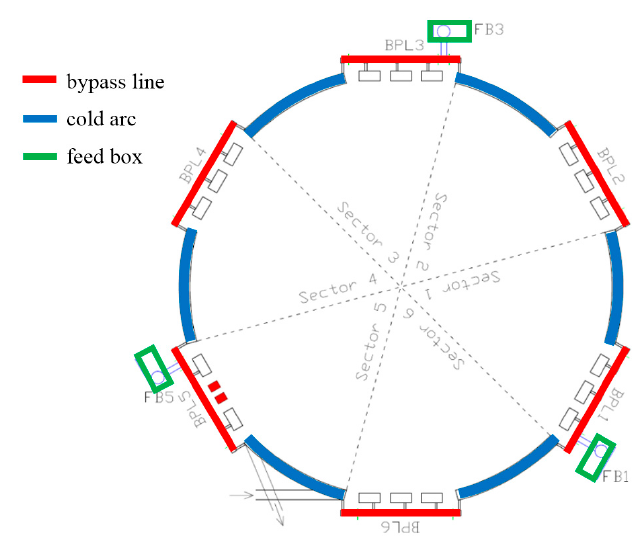
Figure 2. Schematic representation of the SIS100 accelerator showing the six bypass line (BPL) sections. The cold arc sections and BPL sections are for clarity and are not shown in proportion to each other. FB1, FB3, FB5—feed boxes.